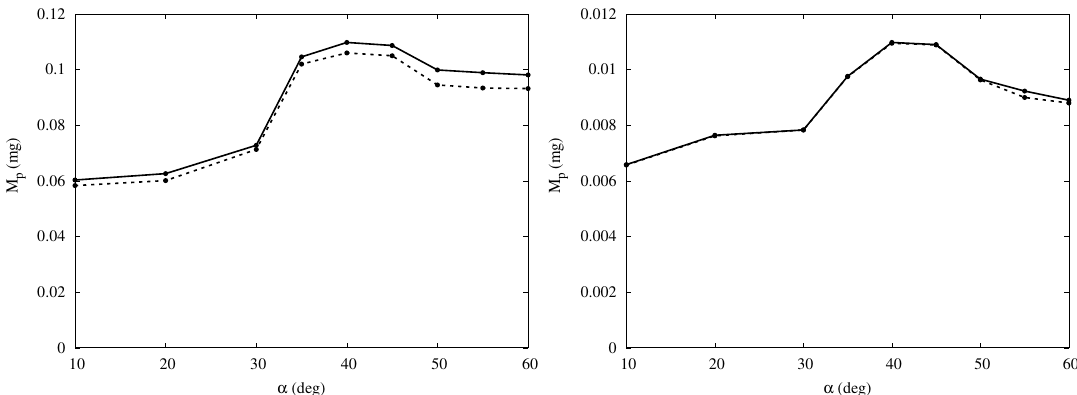
Figure A1. Water mass collected (as droplets) on the semi-ellipsoidal surface for varying body inclinations α and either two-way (solid lines) or one-way (dashed lines) coupling between the two phases. Free-stream velocity is U 0 = 1m/s. Left panel: f p = 3.6 × 10 − 3 ; right panel: f p = 3.6 × 10 − 4